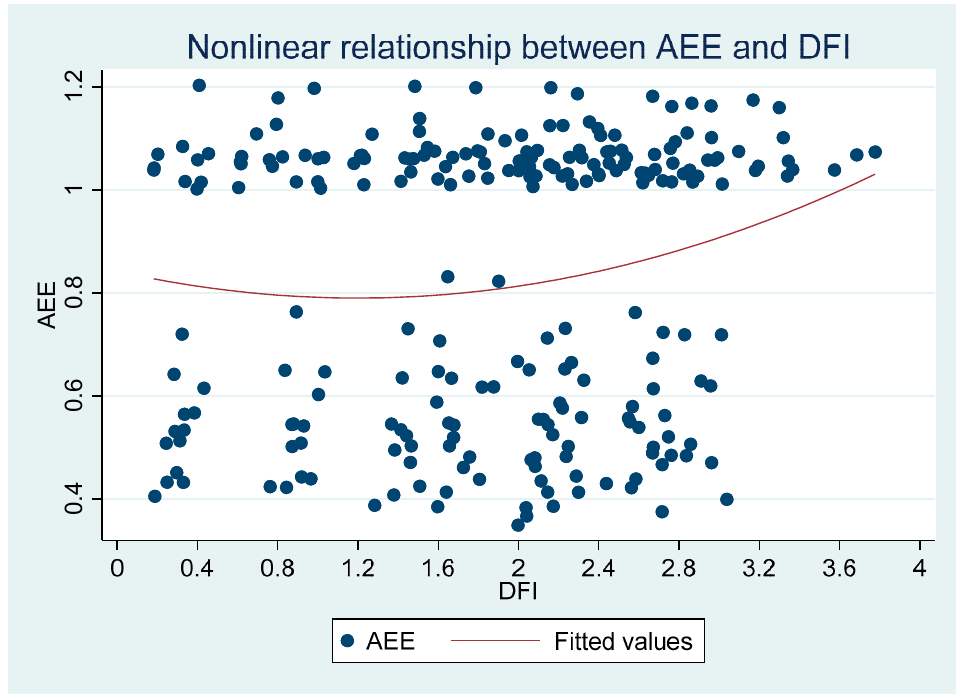
Figure 1. Scatter diagram of AEE and DFI.